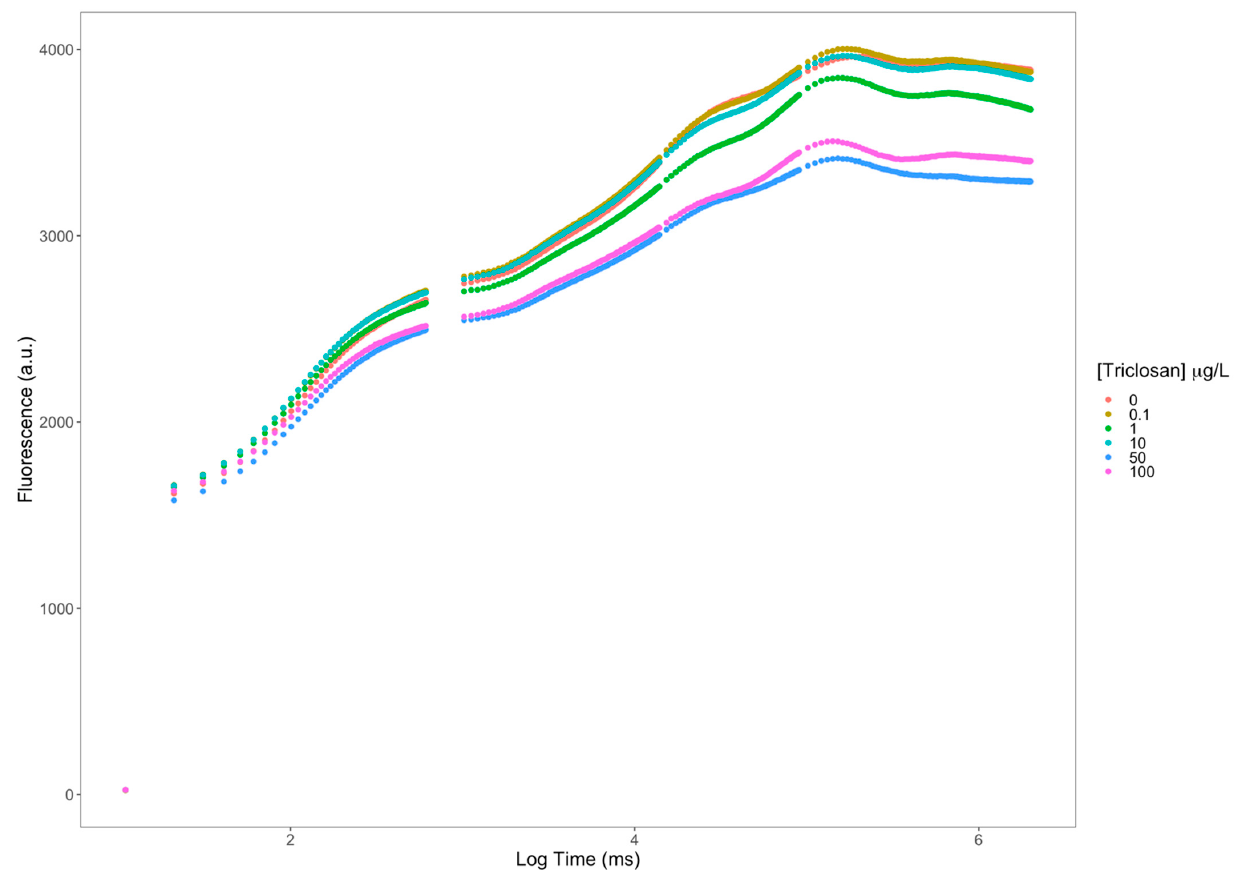
Figure 2. Kautsky plot curves (fluorescence in arbitrary units (a.u.)) from Phaeodactylum tricornutum triclosan-exposed cultures (average; n = 3 per treatment).